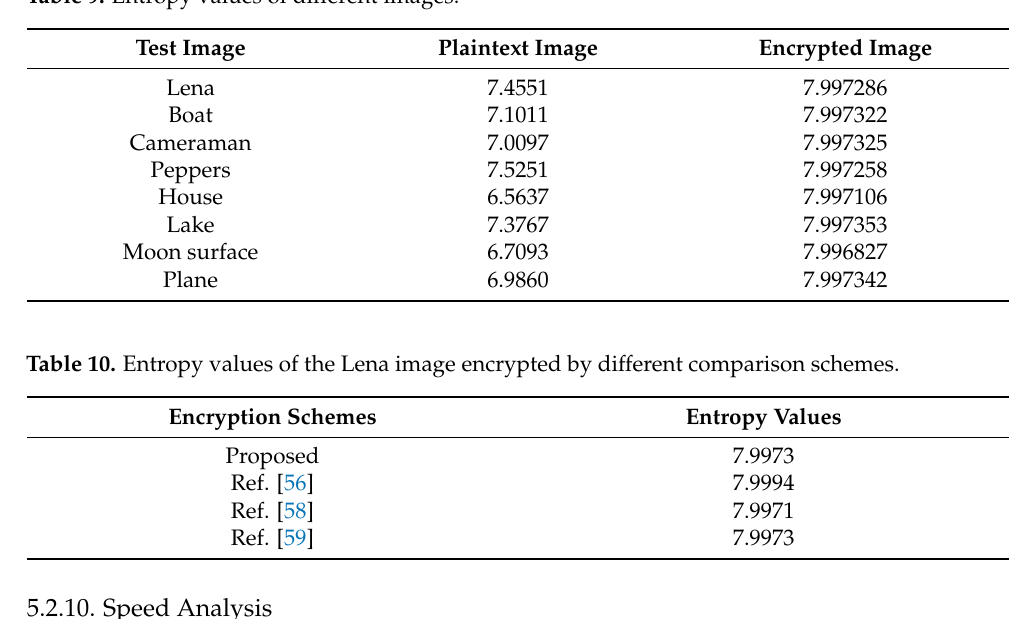
Table 10. The entropy value of our scheme is closer to 8, as shown in Tables 9 and 10, which demonstrates that the scheme proposed is effective. Table 9. Entropy values of different images.